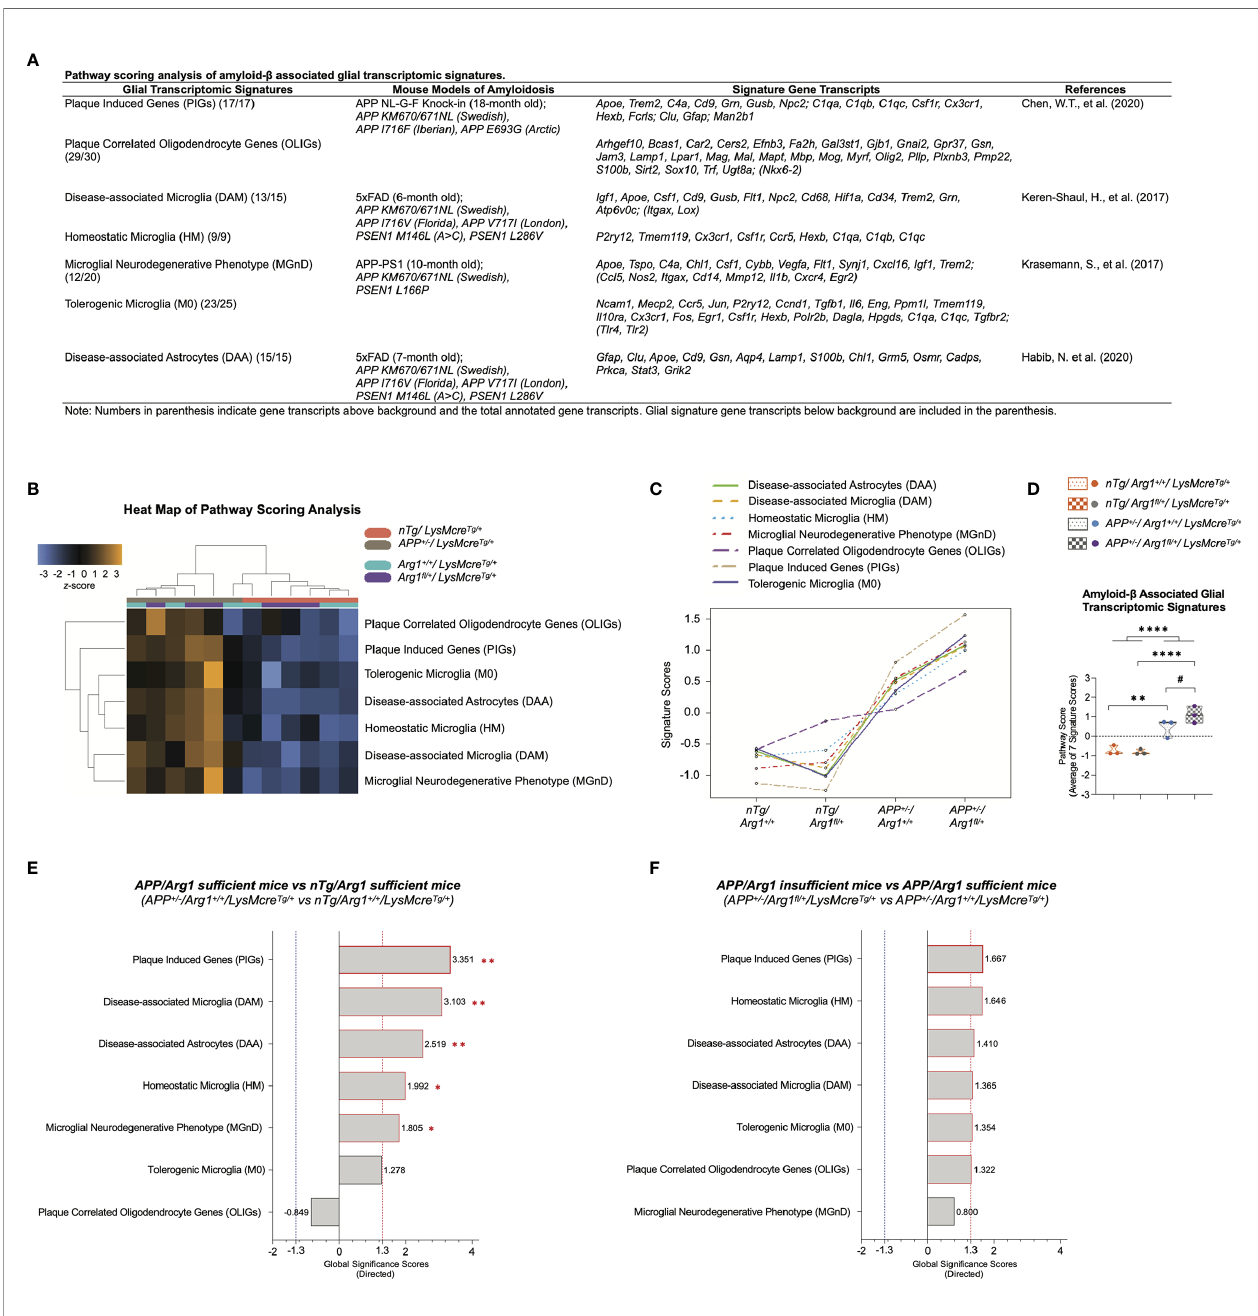
FIGURE 5 | Pathway scoring analysis of amyloid- b associated glial transcriptomic signatures. (A) A table lists seven key glial transcriptomic signatures attributed to amyloid- b stimulus described in recent milestone publications using different mouse models of amyloidosis. (B) A heat map of pathway scoring analysis provides an overview of the glial signature distribution and sample clustering. The z -score color in orange or blue indicates up or down-regulation of glial signature by each sample. All scores are presented on the same scale via a z -transformation. (C) A line plot of seven glial signatures ’ scores shows the transcriptomic changes across groups. Signature cores have been centered to a value of zero. (D) The score of amyloid- b associated glial transcriptomic signatures is summarized as the average of seven glial signatures ’ scores. (E, F) Gene set analysis is presented in bar graphs using directed global signi fi cance scores (GSS) by comparing APP +/- /Arg1 +/+ /LysMcre Tg/+ to nTg/Arg1 +/+ /LysMcre Tg/+ (E) and APP +/- /Arg1 fl /+ /LysMcre Tg/+ to APP +/- /Arg1 +/+ /LysMcre Tg/+ (F) . The red or blue dashed line highlights the top up or down regulated signatures that meet the cut-off criterion (absolute GSS value at 1.3). Also, the statistically signi fi cant signatures from pathway scoring analysis are additionally annotated with red asterisk sign (*). n=3 samples per group representing 6 mice. The asterisk sign (*) indicates the main effect of APP transgene genotype and its pair- wise comparisons. The number sign (#) indicates the main effect of the Arg1 haploinsuf fi ciency genotype and its pair-wise comparisons. * /# p < 0.05, ** p < 0.01; **** p < 0.0001. Two-way ANOVA of 2x2 factorial analysis followed by pairwise comparisons using Fisher ’ s